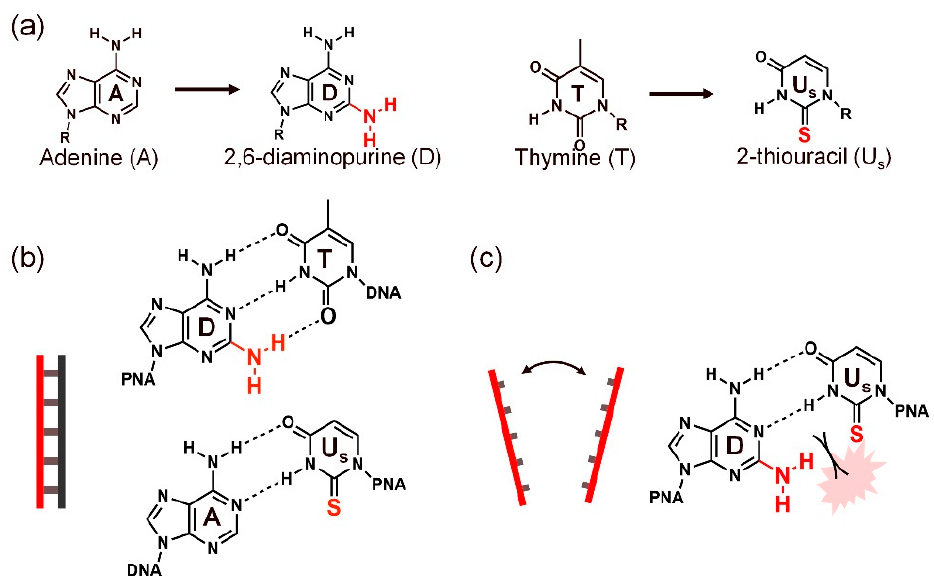
Figure 5. ( a ) The structure of pseudo-complementary nucleobases D and U s . ( b ) D/T base pair has an additional hydrogen bond, and A/U s pairs can avoid steric repulsion, unlike D/U s base pair, resulting in a stable duplex between pcPNA and DNA. ( c ) D/U s base pair has steric repulsion and destabilizes the duplex between two pcPNAs.